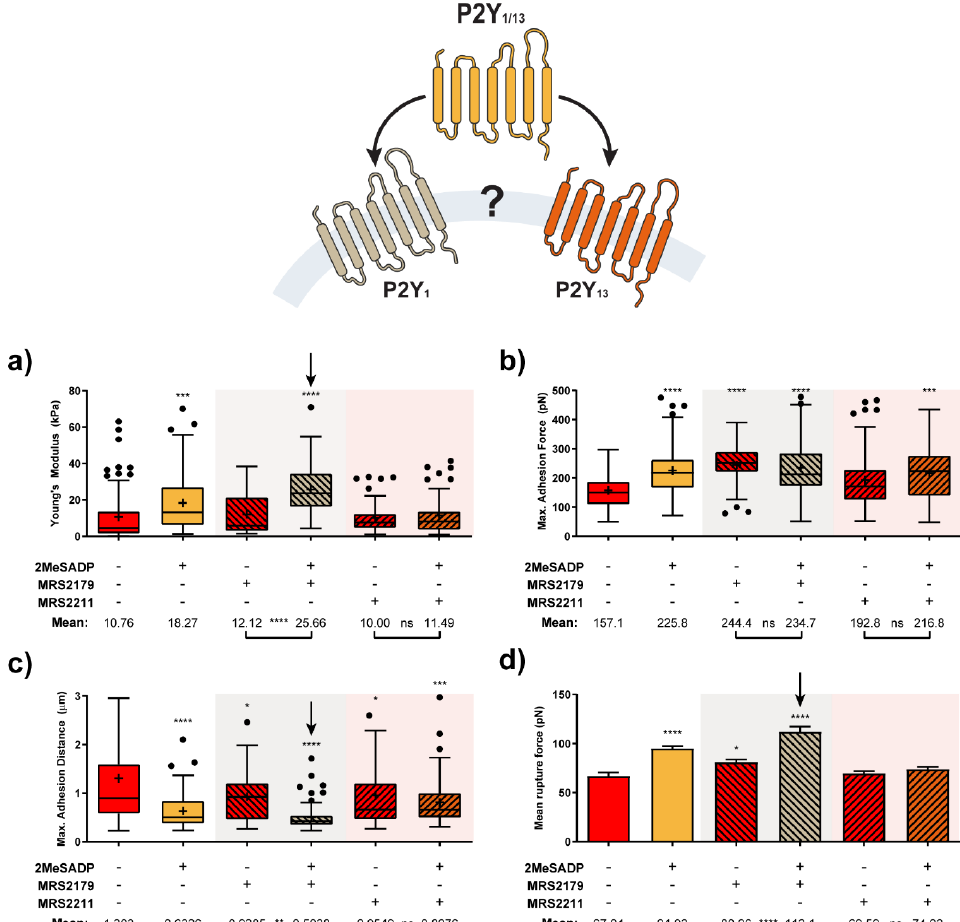
Figure 5. Characterization of ADP receptor mediating 2MeSADP effects observed in cerebellar astrocytes ( N > 15). Calculated Elastic modulus ( a ) adhesion-related ( b , c ) and mean rupture force ( d ) value variation for astrocytes exposed to either MRS2179 and MRS2211 or their subsequent interaction with 2MeSADP receptor agonist. Boxplots ( a – c ) cover the range 25–75%, being the horizontal line indicative for the median, and the cross for the mean value, which are shown numerically below. Whiskers indicate 5 and 95%, while black dots refer to outliers. Columns in ( d ) indicate the mean ± S.E.M. of each condition. Statistically relevant variations p < 0.05, p < 0.01, p < 0.001 and p < 0.0001 are highlighted by *, **, *** and ****, respectively, while not significant variations ( p > 0.05) are indicated by